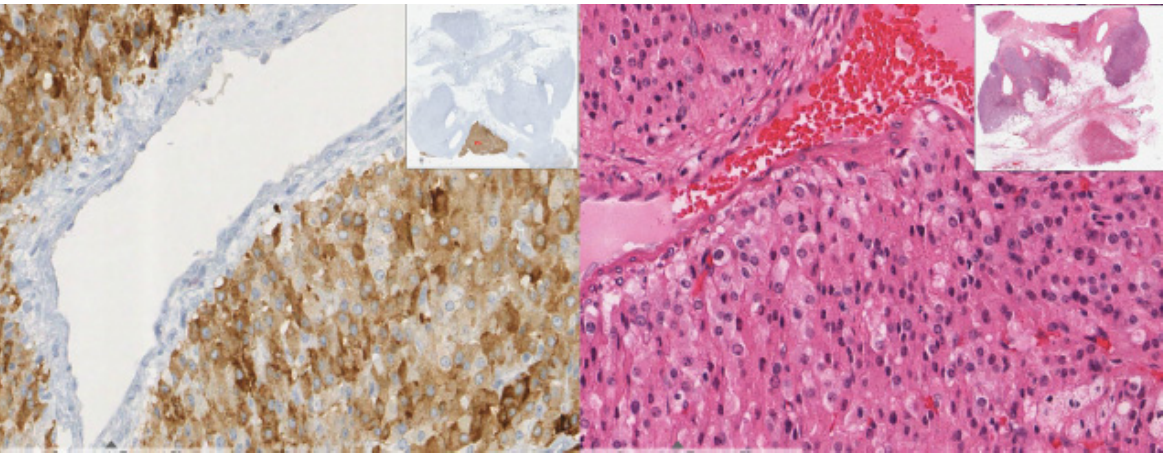
Figure 5. (20x): Inhibin stain: diffuse cytoplasmic staining of carcinoma component. Immunohistochemistry (IHC) for comparison.